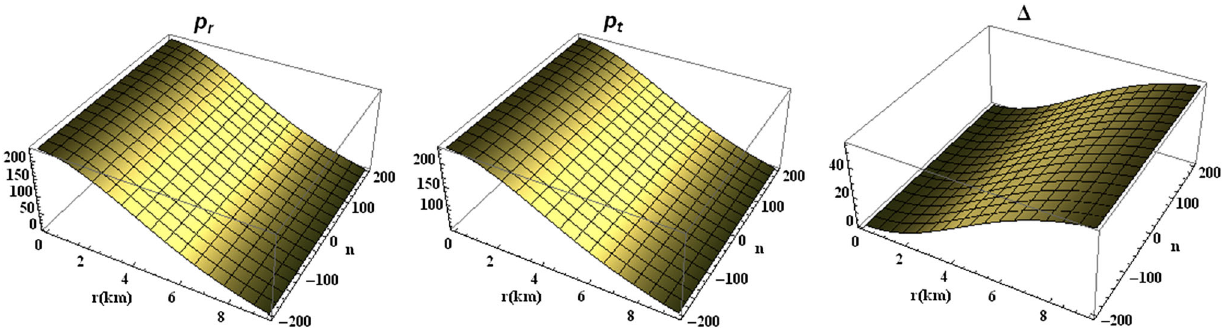
Fig. 1 (Left) In this figure, along x -axis, y -axis and z -axis we have respectively plotted the radius of the star in km unit, the dimensionless quantity n which lies in the range − 200 ≤ n ≤ 200 and the met- ric co-efficient e λ which is a dimensionless quantity. (middle) along x -axis, y -axis and z -axis we have respectively plotted the radius of the star in km unit, the dimensionless quantity n which lies in the range − 200 ≤ n ≤ 200 and the metric co-efficient e ν which is a